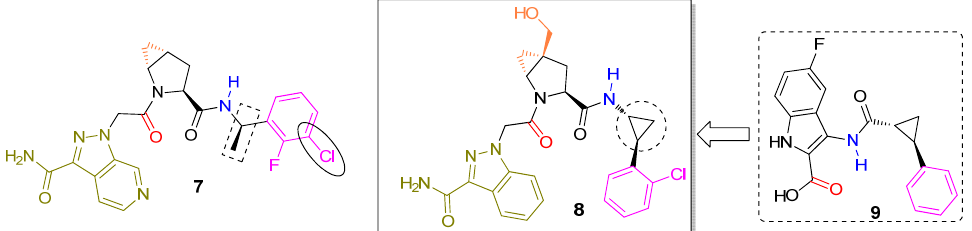
Figure 6. Additional lead structures of (S)-proline-based latent FD inhibitors. Molecule 8 was included in a published patent publication ( WO2014/002051 , Novartis). It was the most potent inhibitor among 87 analogs synthesized and tested in the human FD thioesterolytic assay (IC 50 = 0.022 µM).